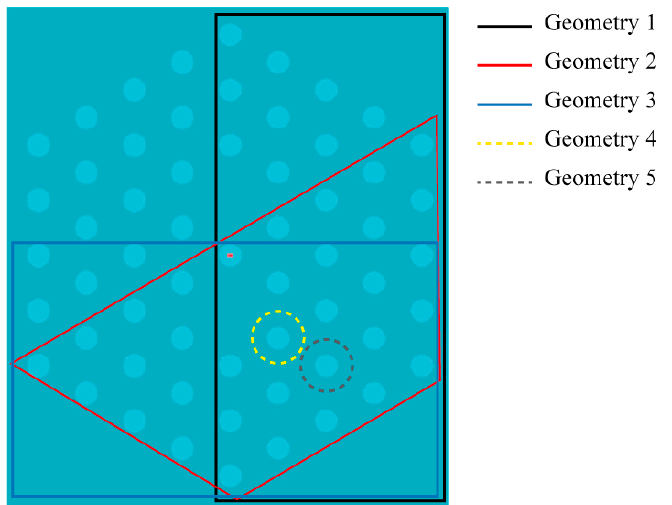
Figure 6. Illustration of the selected regions in the microstructure where geometrical perturbations are applied. The perturbation consists in increasing slightly the size of the holes within the selected region.